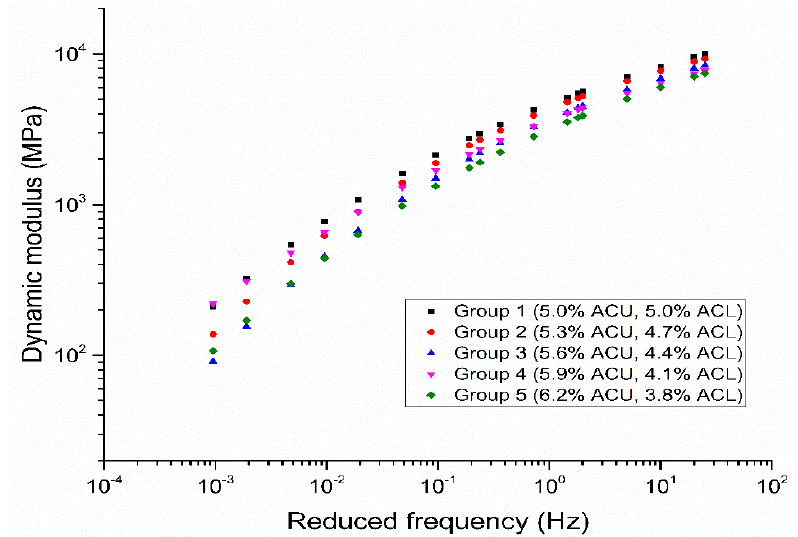
Figure 7. The master curves of dynamic modulus of five groups of samples (reference temperature: 20 °C).